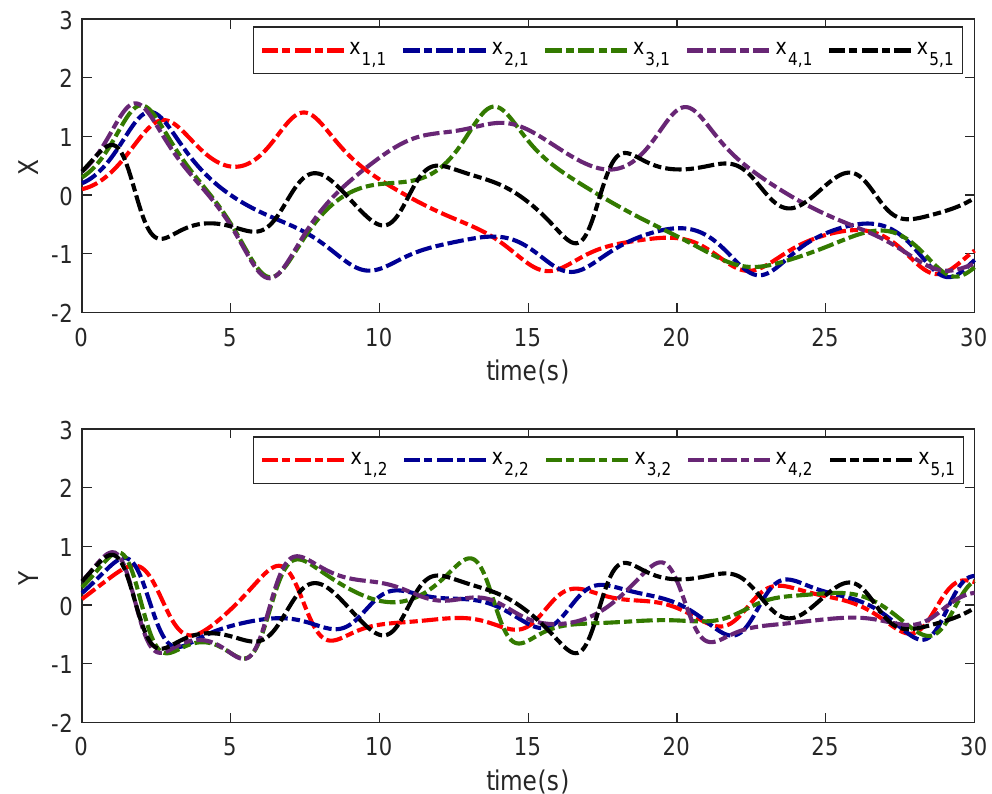
Figure 3. Trajectories of system states without control